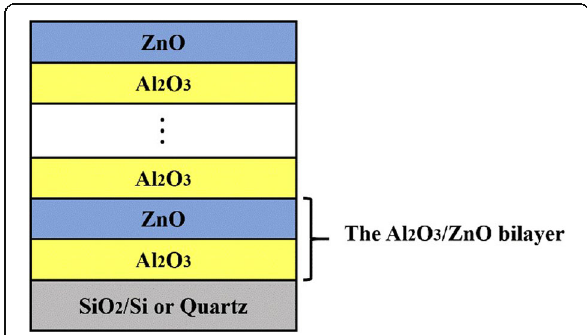
Fig. 1 The structure diagram of the Al 2 O 3 /ZnO